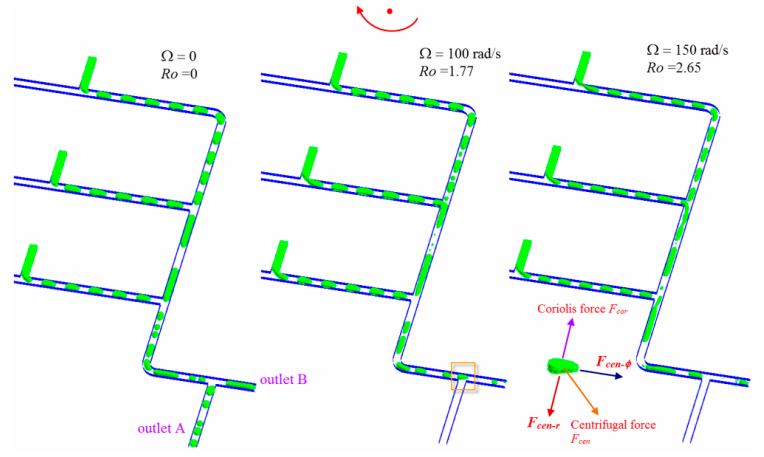
Figure 7. Sedimentation of cell-encapsulated droplets at the separation junction.